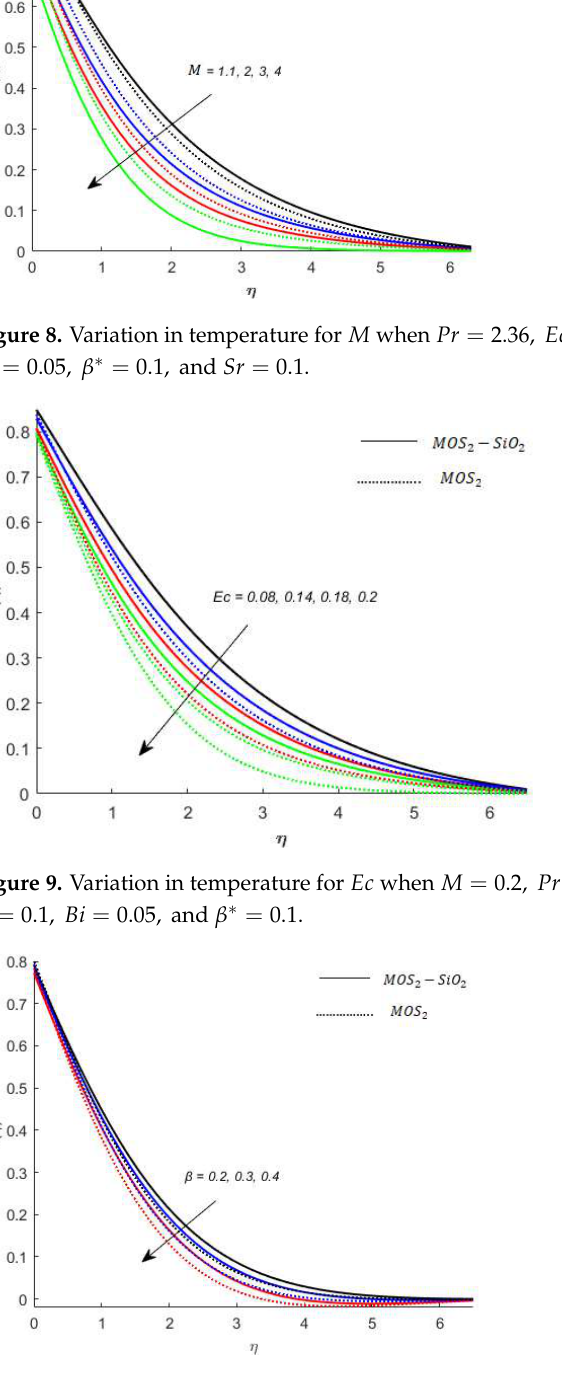
Figure 10. Variation in temperature for 𝛽 when 𝑀 = 0.2,𝑃𝑟 = 2.36,𝑆𝑟 = 0.1,𝑆𝑐 = 0.8, (𝐺𝑟) (cid:3030) = 0.1,𝐾 = 0.1,𝐵𝑖 = 0.05,and 𝛽 ∗ = 0.1.